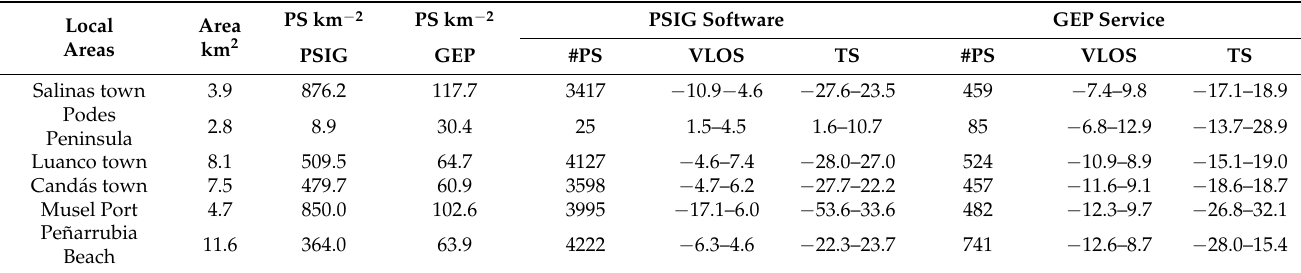
Table 3. A-DInSAR results for each local area selected: #PS—Number of points detected; VLOS—LOS mean deformation velocity rates in mm year − 1 ; TS—minimum and maximum deformation accumulated in mm. Local